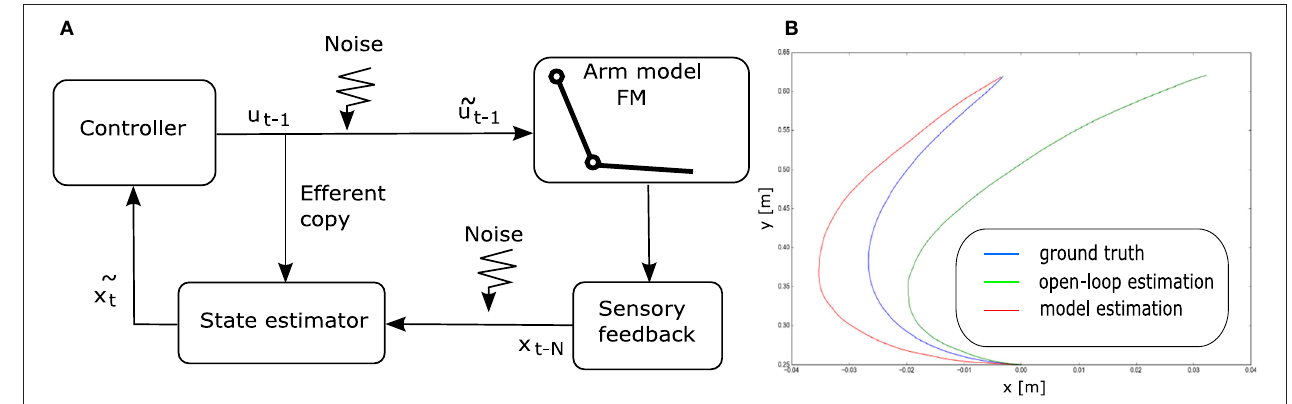
FIGURE 6 | (A) A standard schematic view of human motor control (see e.g., Scott, 2004). (B) Illustration of the state estimation dynamics. The open-loop term (in green) diverges from the perturbation-free “ground truth" trajectory (in blue). The model state estimation (in red) diverges in the accelerating phase of the movement, but the closed-loop term makes it converge again toward ground truth when the end-effector decelerates.